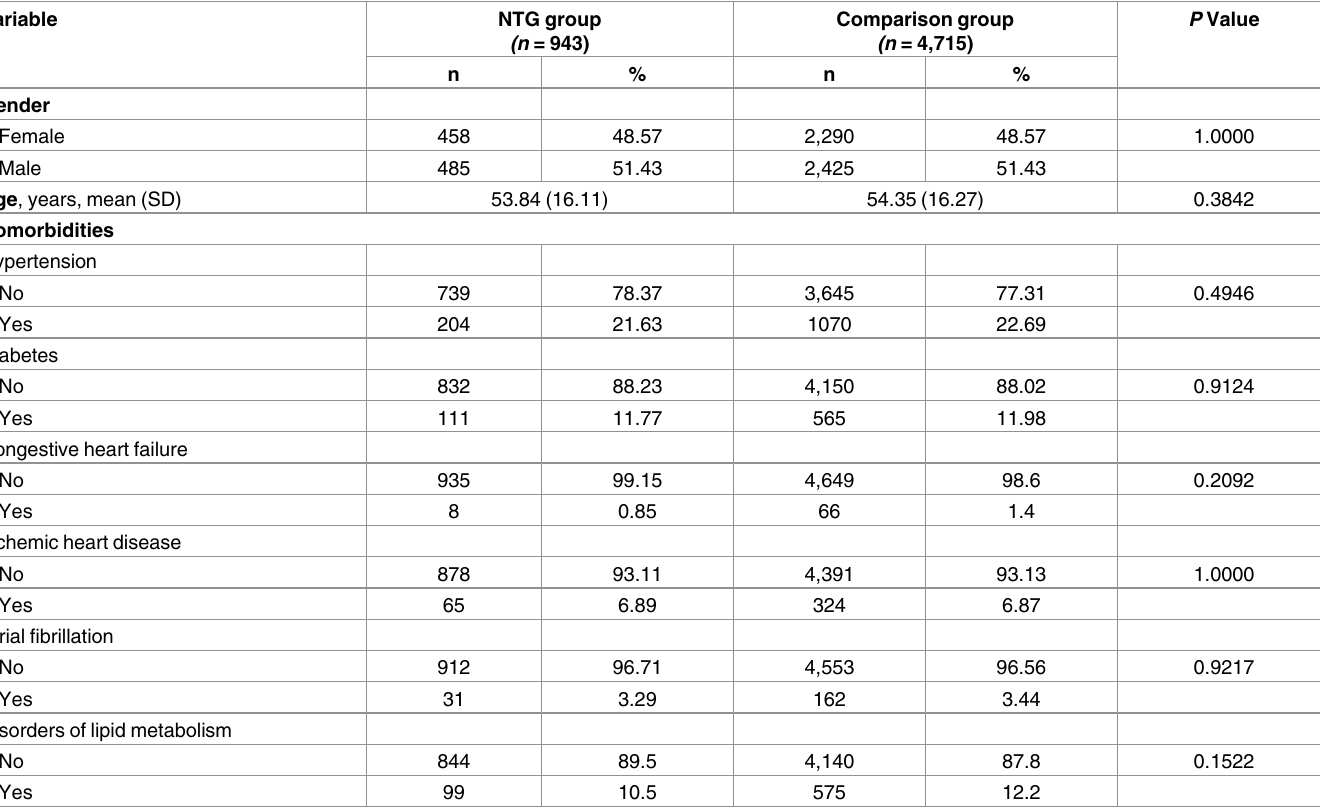
Table 1. Demographic characteristics and comorbid medical disorders for patients with NTG and patients in a comparison group in Taiwan, 2001– 2010 (N = 5,658). Variable NTG group